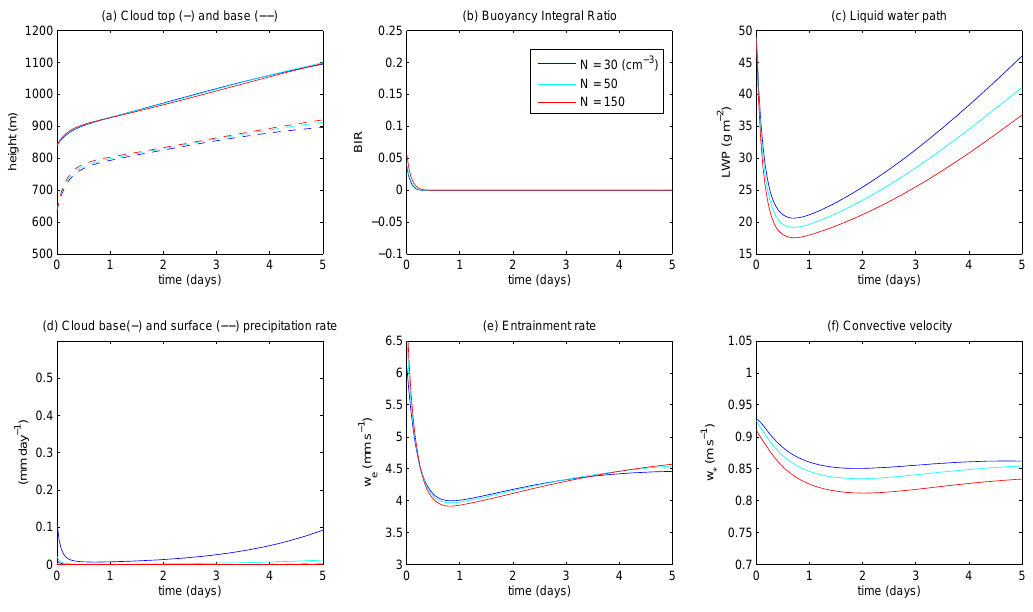
Fig. 7. MLM time series as in Fig. 3 but with a 2 =110 and LES-tuned cloud base drizzle.